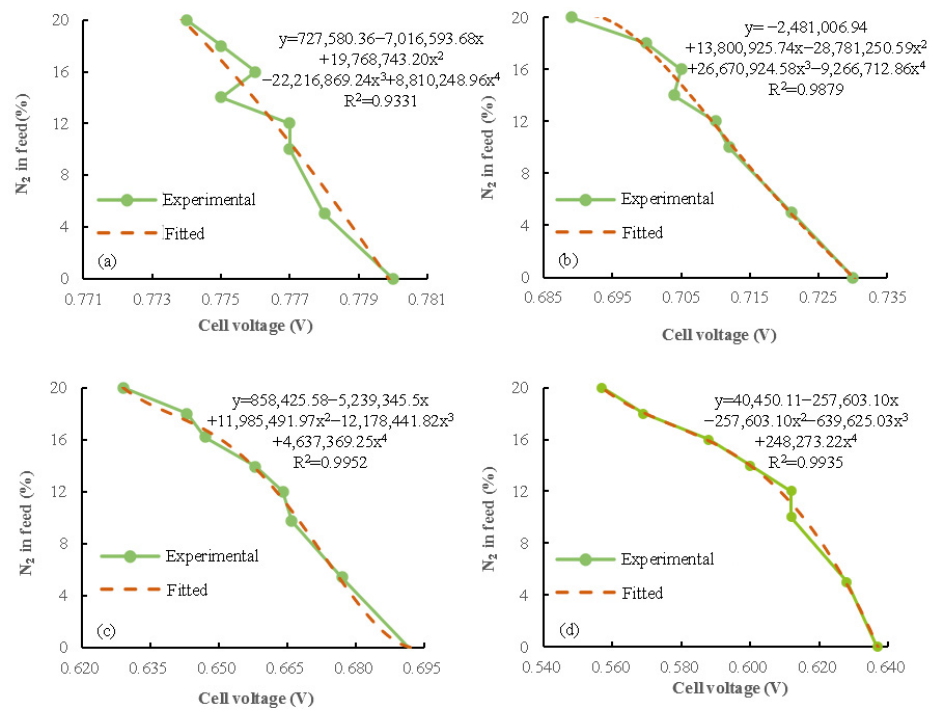
Figure 7. Fitting results of cell 11 at different current densities: ( a ) 0.2 A ∙ cm − 2 ; ( b ) 0.6 A ∙ cm − 2 ; ( c ) 1.0 A ∙ cm − 2 ; ( d ) 1.4 A ∙ cm − 2